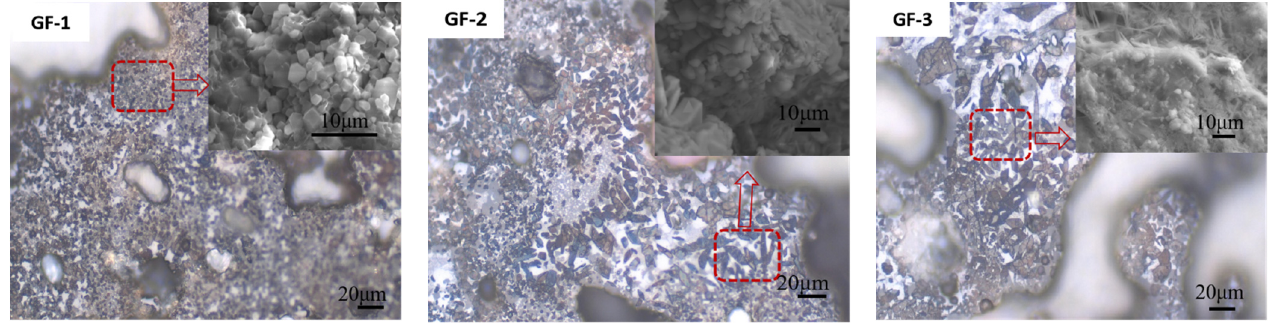
Figure 1. The morphology of the BBSC clinkers (inserts are the ESEM patterns).